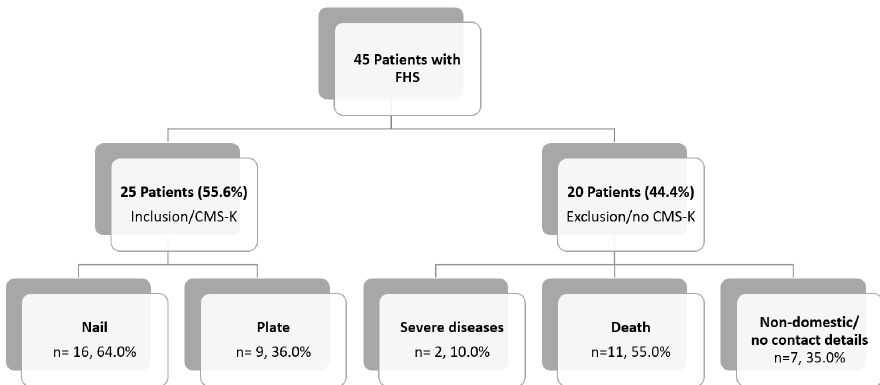
Figure 5. Reasons of inclusion/exclusion of patients with FHS from 2004 to 2013. FHS: combined fractures of humeral head and shaft; CMS-K: Constant–Murley Score, age- and gender-adapted according to Katolik. Table 1. Patient characteristics; fracture classifications according to Neer, AO/OTA proximal and metaphyseal, Stedtfeld, and Garnavos/Lasanianos; used implants; follow-up with outcome; and observed revisions.